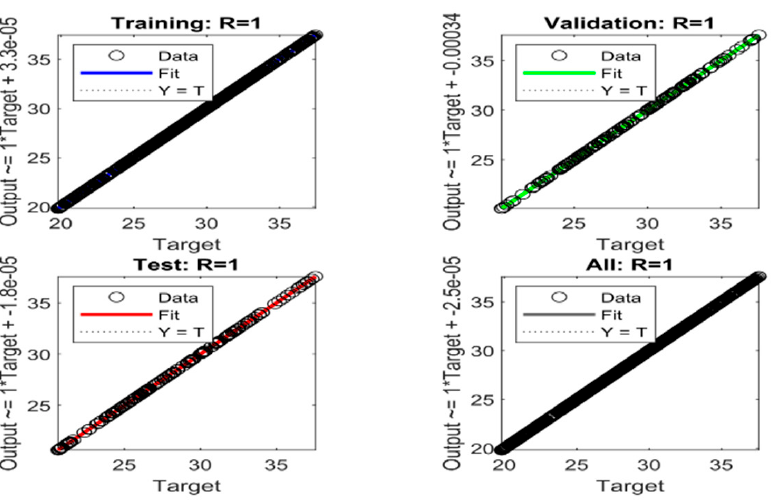
Figure 6. The regression diagram for trained data.